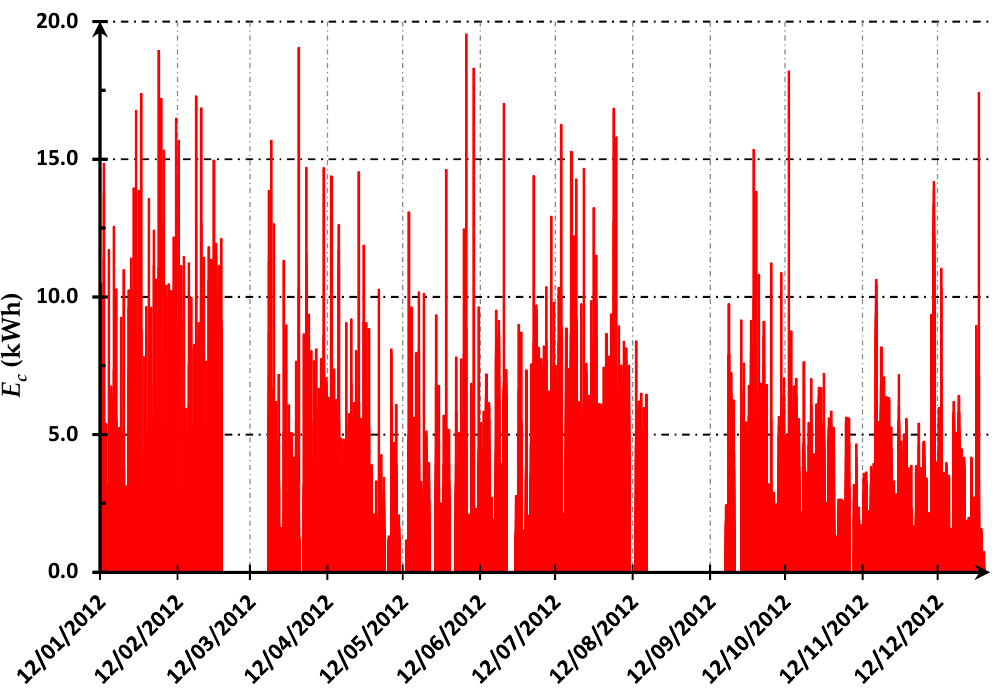
Figure 10. Consumption of active energy (Ec) in 2012.